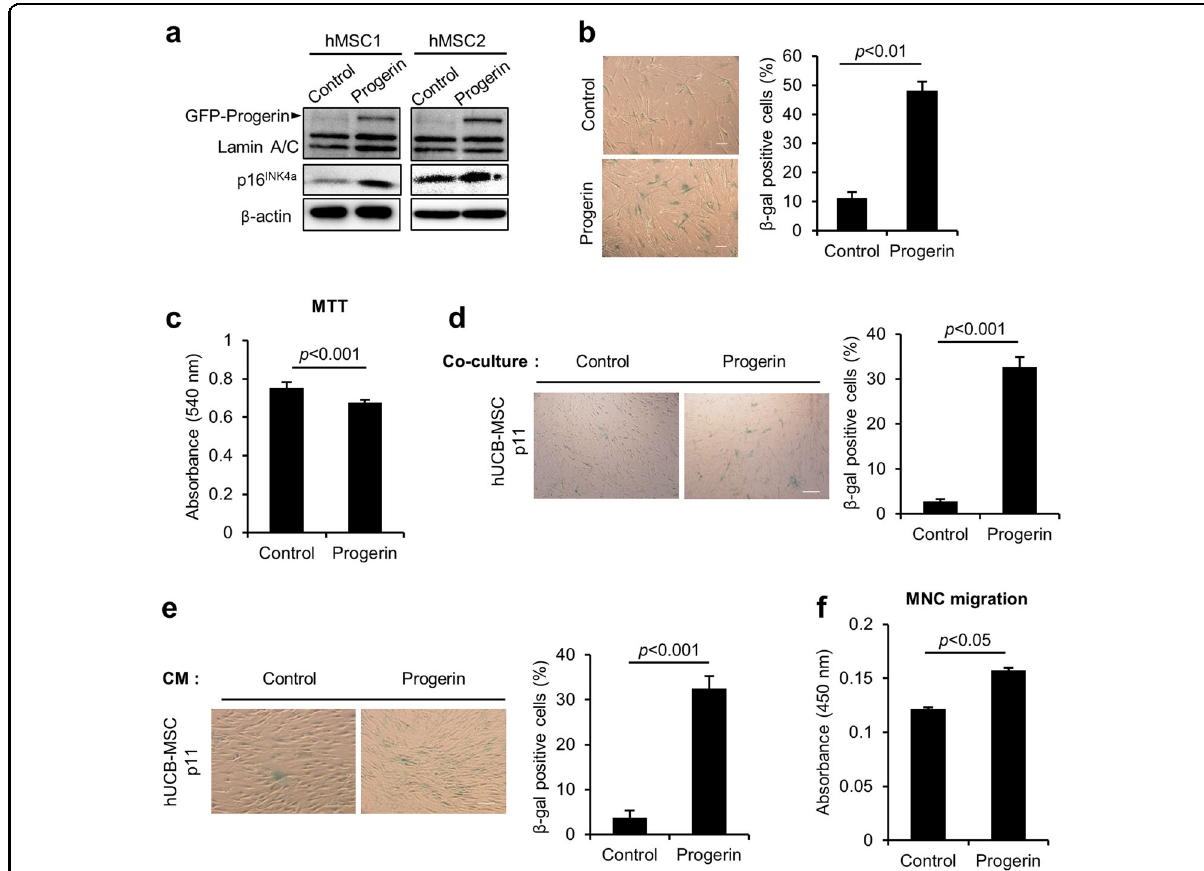
Fig. 1 Progerin overexpression triggers senescence in hMSCs, including secretory phenotypes. a – f hMSCs were infected with retroviruses encoding GFP-progerin to induce senescence or with the control vector at the same MOI. The cells were selected for 4 days with 0.5 μ g/ml puromycin. After the selection, cells were cultured for 3 days before the analysis. a Immunoblotting analysis showing the overexpression of GFP- progerin protein and increased expression of p16 INK4a in hMSCs. b (Left) Representative images of hMSCs stained for SA- β -gal after senescence induction by progerin. (Right) Quanti fi cation of percentage SA- β -gal-positive cells. Scale bar = 300 μ m. c MTT assay to assess the proliferation of control and progerin-expressing MSCs ( n = 3). d , e (Left) Representative images of SA- β -gal staining of hMSCs. (Right) Quanti fi cation of percentage SA- β -gal-positive cells ( n = 3). d hMSCs were co-cultured with control and progerin-overexpressing cells for 4 days in a Transwell chamber, and SA- β - gal activity was measured. Control and progerin-expressing cells were seeded in the upper chamber, and normal hMSCs were cultured in the lower chamber. The Transwell chamber blocks physical contact between upper- and lower-chamber cells. Scale bar = 100 μ m. e hMSCs were cultured with CM from control and progerin-expressing hMSCs for 4 days, and SA- β -gal staining was performed. Scale bar = 200 μ m. f Mononuclear cells isolated from human umbilical cord blood were placed in the top chamber, and CM from control or progerin-expressing MSCs was introduced in the lower chamber. Cell migration was evaluated following 6 h of exposure using CCK-8 ( n = 3). Error bars represent means ± s.d. from three